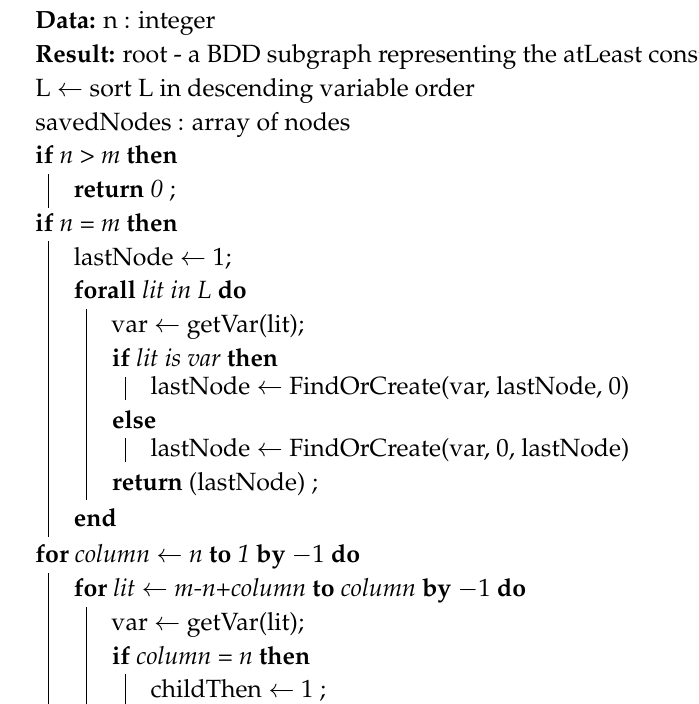
Algorithm 2: Direct construction of the BDD for atLeast − n primitive Data: L - a list of literals of size